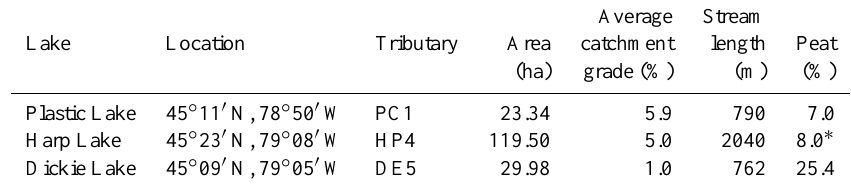
Table 1. Location and basic characterization of study catchments (Dillon et al., 1991; ∗ Kothawala et al., 2006).